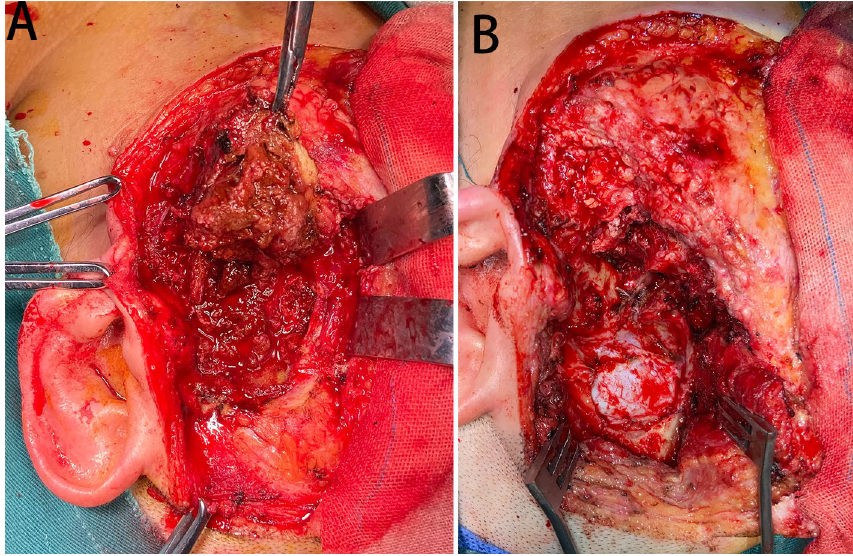
Figure 3. Representative histology from patient 9. Intraoperative photos of tumor resection showed the lesion was removed ( A and B ).